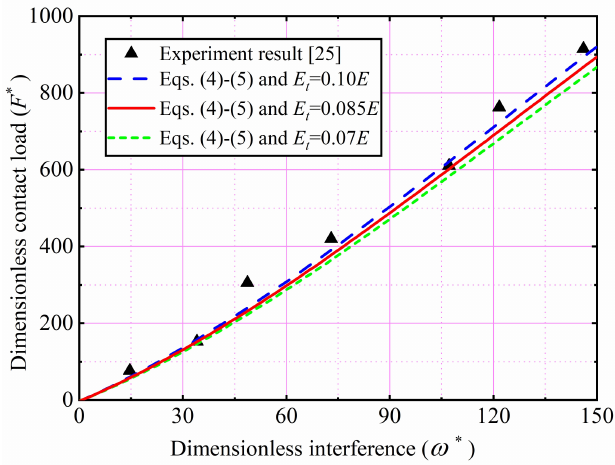
Figure 10. Comparisons of F * as the function of ω * predicted by the present model and experiment results at k e = 1 and 0.07 ≤ E t /E ≤